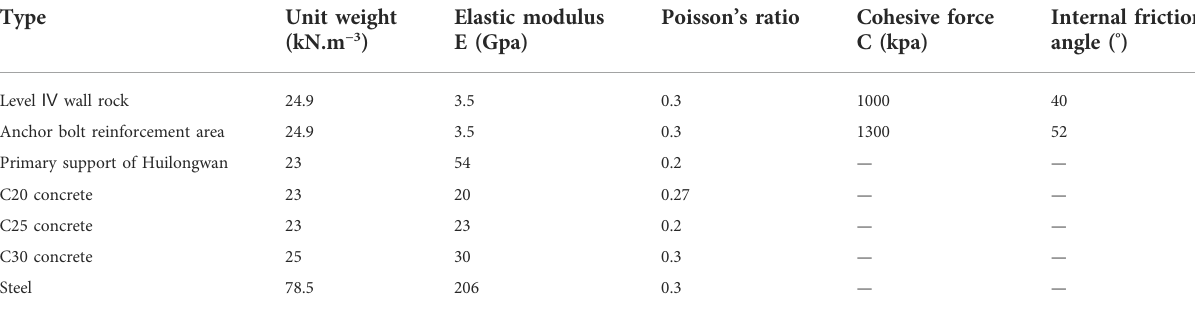
TABLE 1 Physical and mechanical parameters of the tunnel support